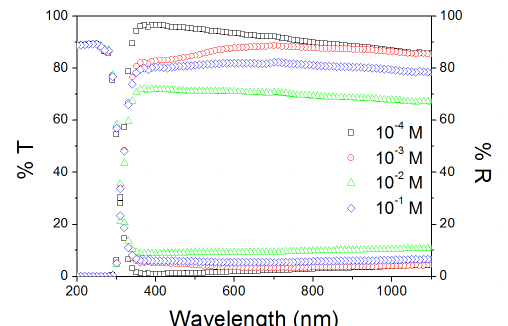
Fig. 4. Transmittance (T) and reflectivity (R) of the thin films at different deposition concentrations.